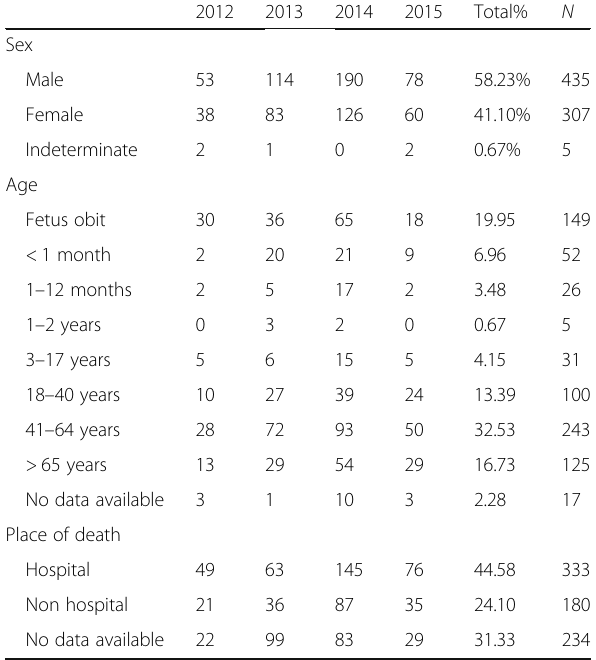
Table 1 Demographic characteristics of study population